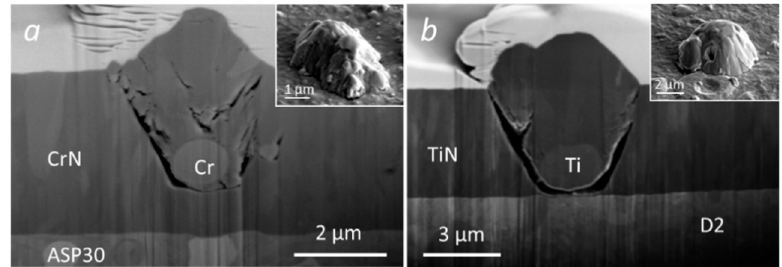
Figure 26. Typical droplet-related defects in CrN ( a ) and TiN ( b ) hard coatings prepared by cathodic arc evaporation.